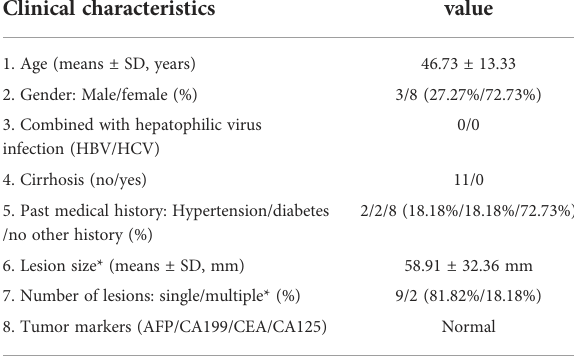
TABLE 1 Summary of general information and clinical features of patients. Clinical